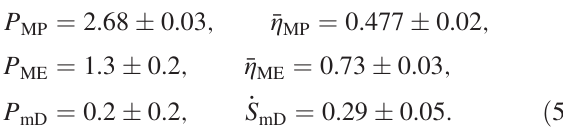
FIG. 2. Asymmetry of Onsager coefficients. (a) ð L 12 − L 21 Þ = ð L 12 þ L 21 Þ versus temporal asymmetry. The red markers denote the experimental results, the solid black line the theoretical curve. T 0 ¼ 2 . 5 and F 0 2 − 10 to þ 10 for each ε . Work rates _¯ W cycles. (b) Illustration of the driving function g 2 ð t 0 Þ , for ε ¼ 0 . 5 (red line, asymmetric), compared to the symmetric case, ε ¼ 0 (black line, symmetric).